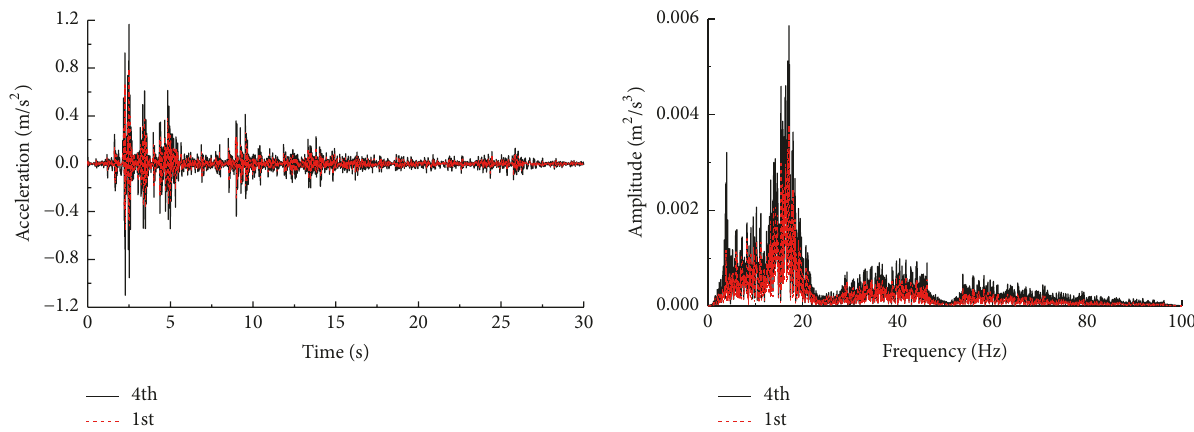
Figure 9: Vertical acceleration time history and corresponding Fourier spectrum curves at node 103 on the 4th floor and node 18 on the 1st floor under standard case